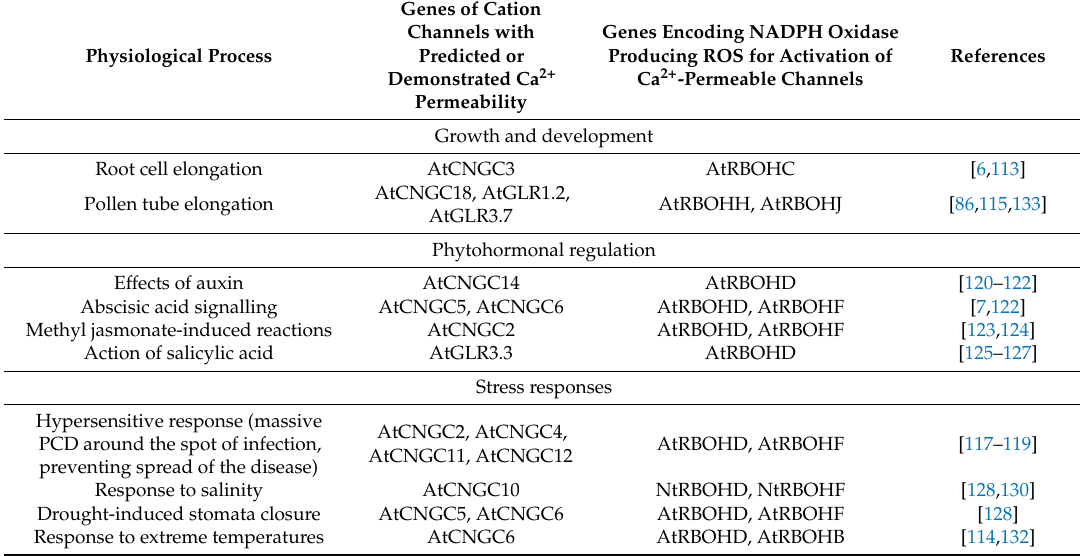
Table 1. NADPH oxidases and cation channels, which can potentially function as ROS-Ca 2+ hubs in key physiological reactions (see hypothesis on ROS-Ca 2+ hubs in the text).